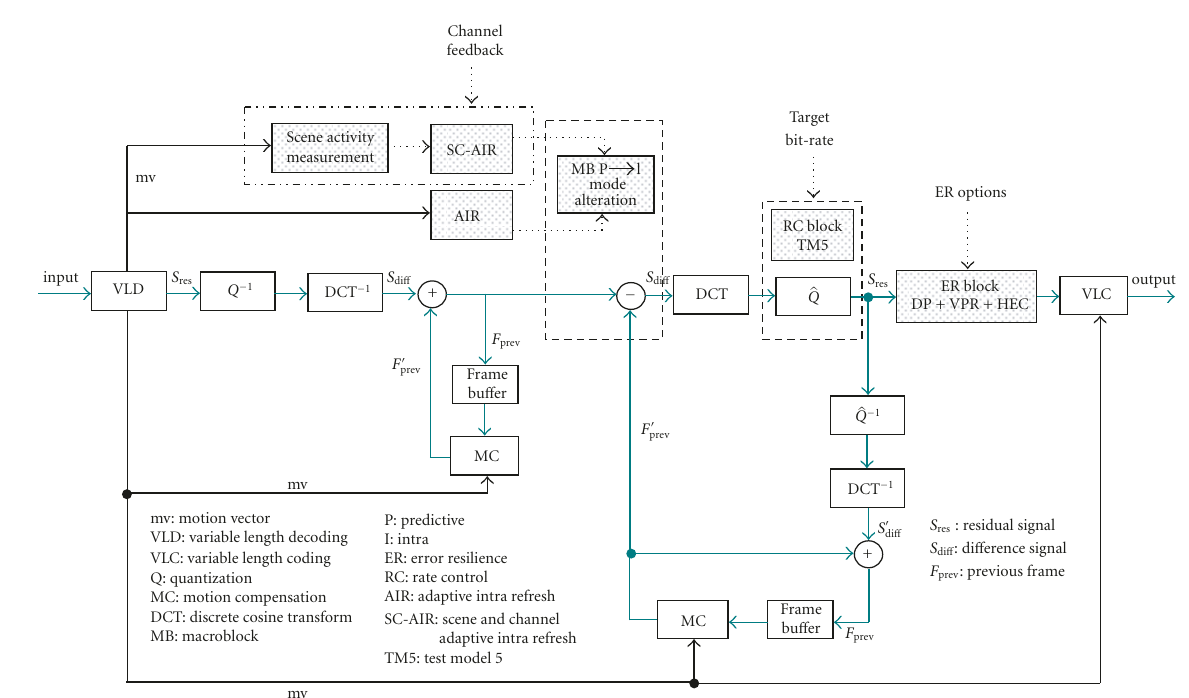
Figure 1: Block diagram of the error resilience and rate control capable video transcoding